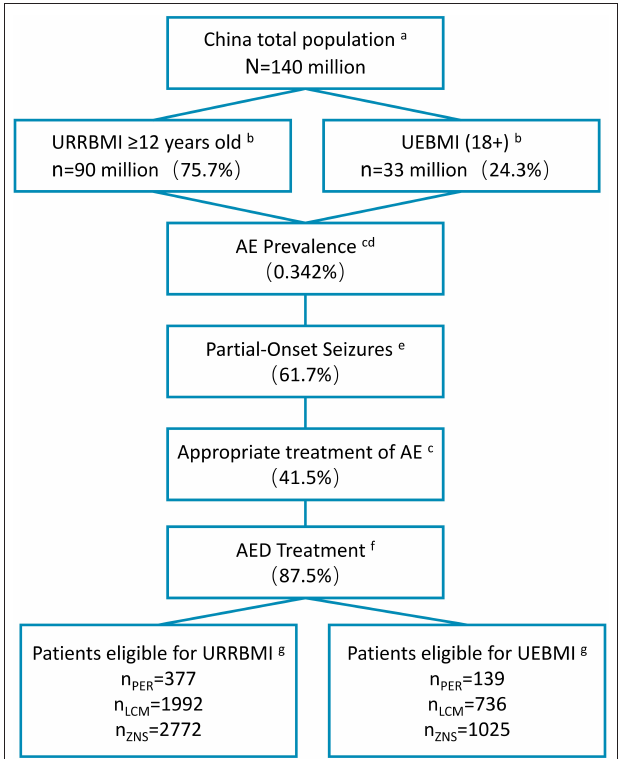
FIGURE 2 | Patient disposition in BI model (2020). a Data from the National Bureau of Statistics of China (data.stats.gov.cn). b Basic medical insurance participation data from reports of medical insurance bureau (nhsa.gov.cn), and proportion of people over 12 years old from 2010 Census Report (data.stats.gov.cn). c Prevalence of active epilepsy and rate of standardized treatment from Ding et al. ( 10). d Annual growth rate of the prevalence during 2021–2023 from Song et al. (34) e Proportion of patients with partial seizures from Yu et al. ( 2). f Standardized treatment rate of drugs from investigation results of 18 clinical experts. g Market shares of three drugs provided by Eisai Co., Ltd. ( Table 4 ). BI, budget impact; URRBMI, Urban Rural Resident Basic